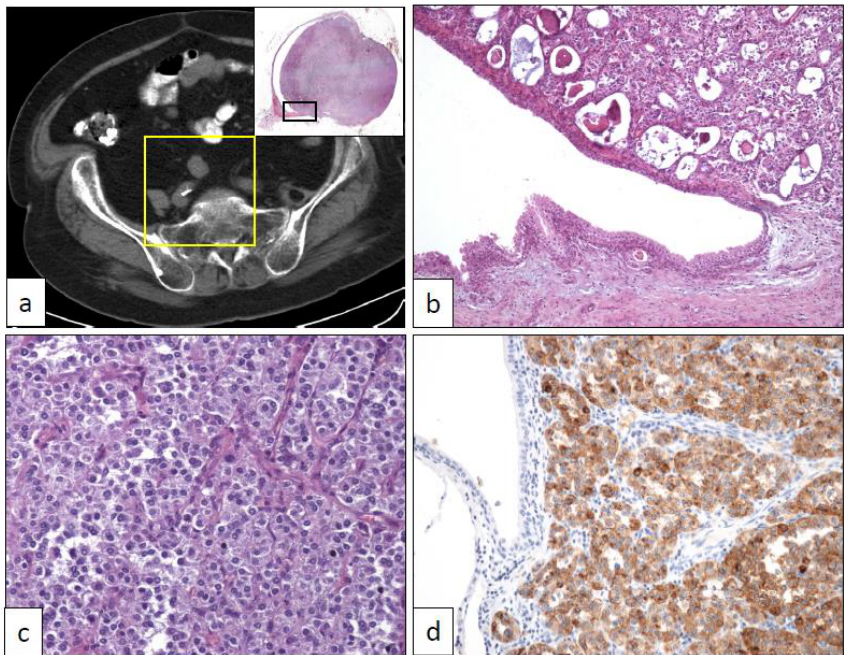
Figure 5. ( a ) Conventional PEComa arising in the right ureter (yellow square in the CT scan shows the panoramic view of a transverse section of the ureteral hourglass tumor in the upper right inset), ( b ) low-power view of the ureteral tumor corresponding to the rectangle black inset in ( a ) (40 × ), ( c ) medium-power view of the tumor showing solid cell nests with an epithelioid appearance (250 × ), ( d ) intense positivity with HMB-45 immunostaining (250 × ).